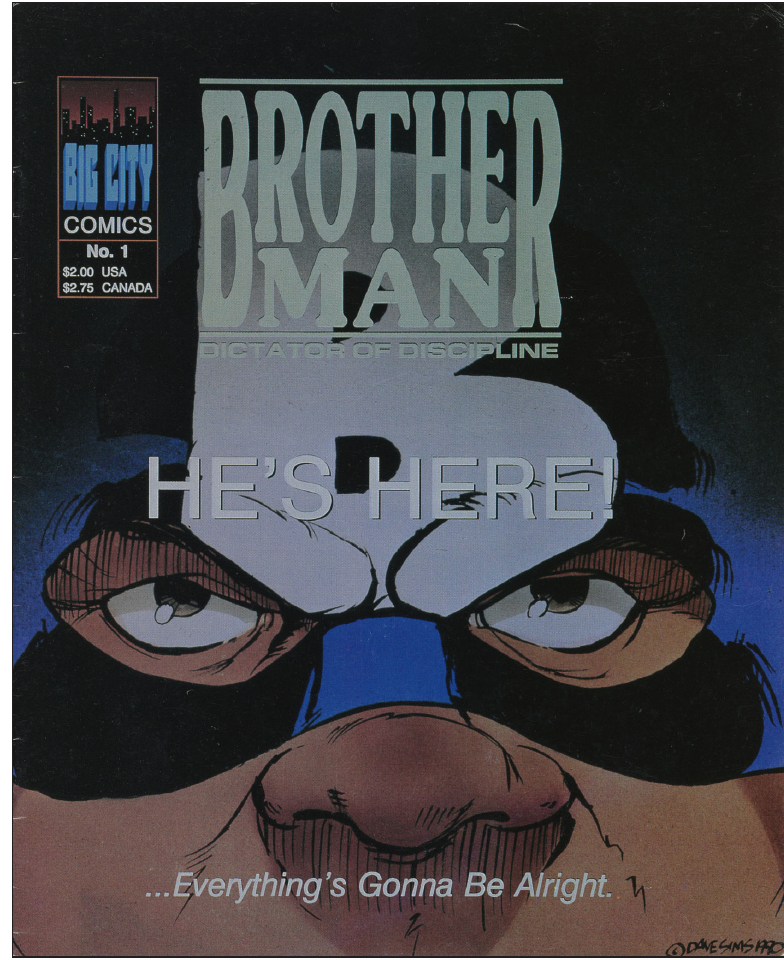
Figure 1: Cover of Sims J, Sims D, and Sims G (1990a) Brotherman: Dictator of Discipline #1 (East Orange, NJ) © Big City Entertainment,